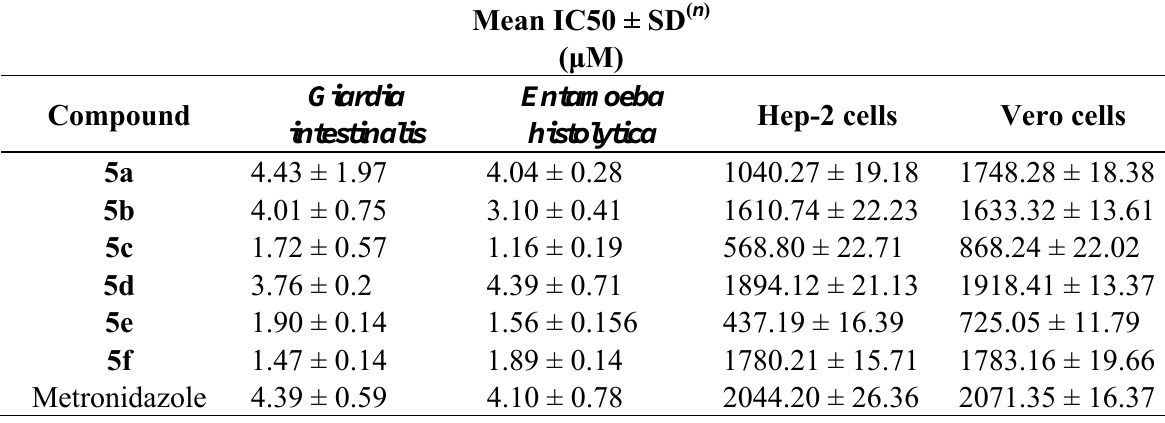
Table 1. Antiparasitic activities of compounds 5a-f .